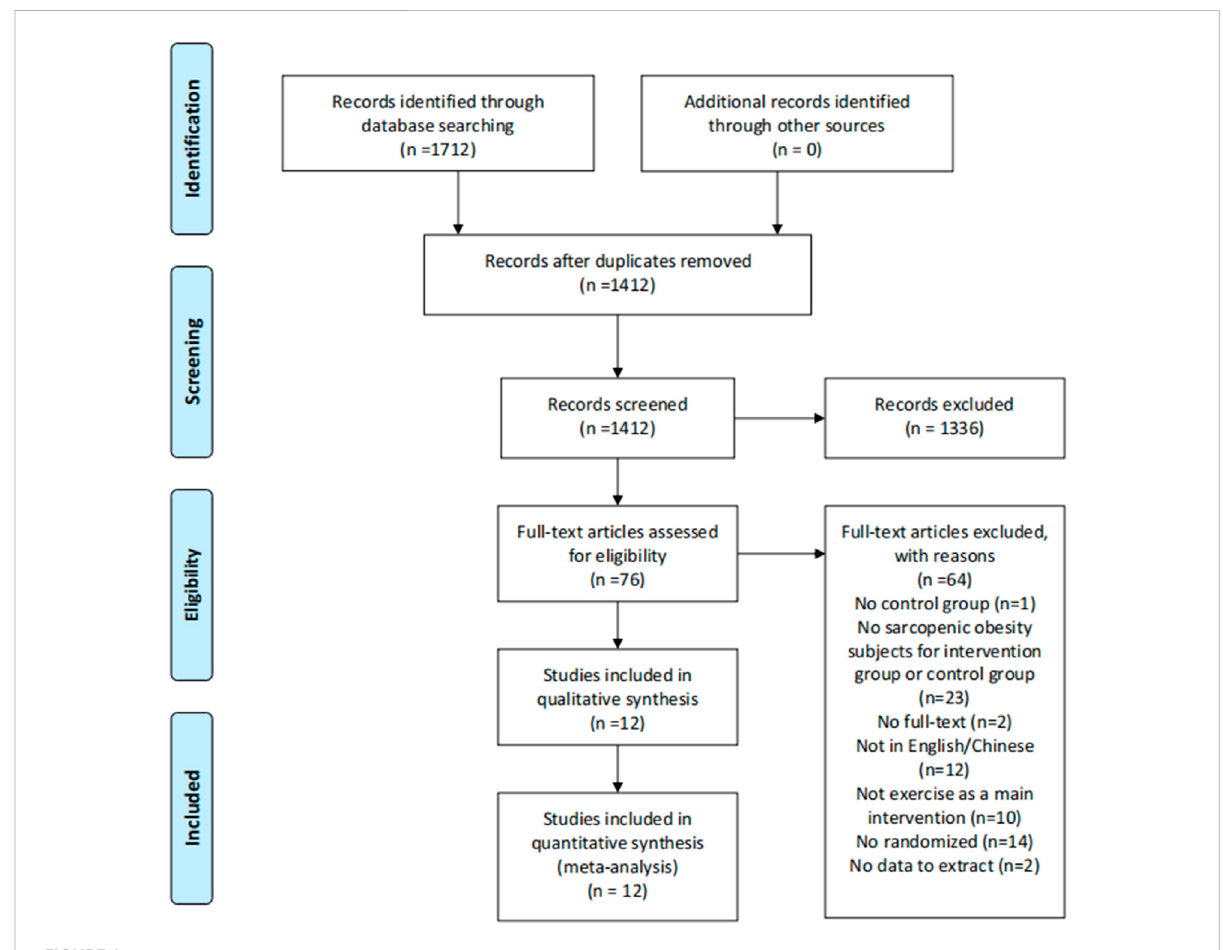
FIGURE 1 Flow of screening and selecting process according to preferred reporting items for systematic reviews and meta-analysis